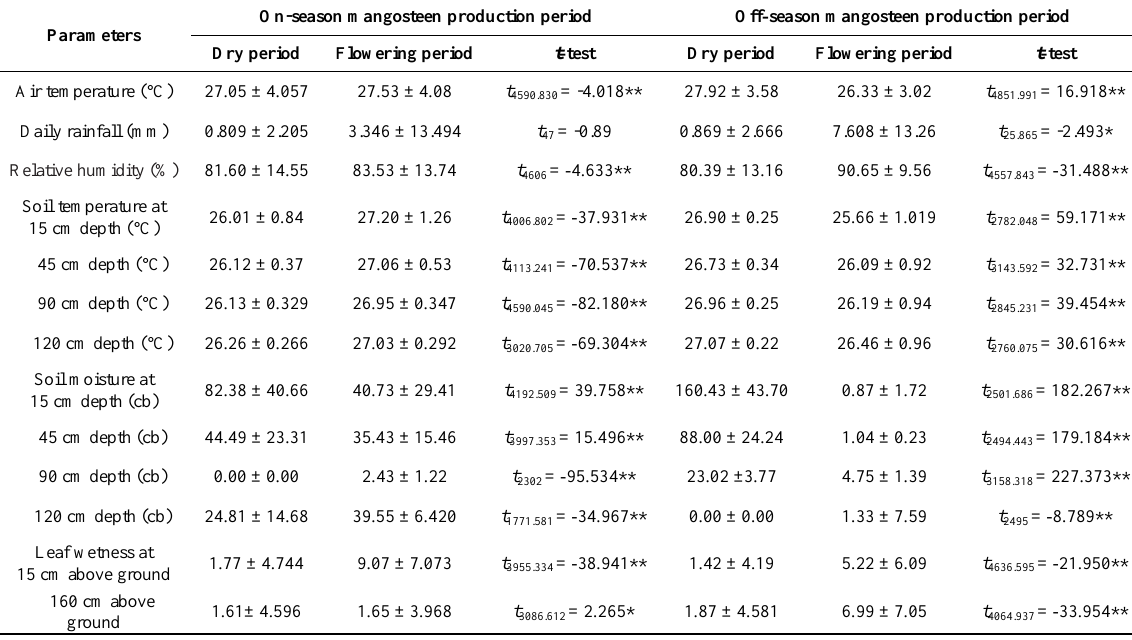
Table 1. Climatic and soil factors between the dry and flowering periods of the on-season and off-season mangosteen production periods (* P < 0.05, ** P <